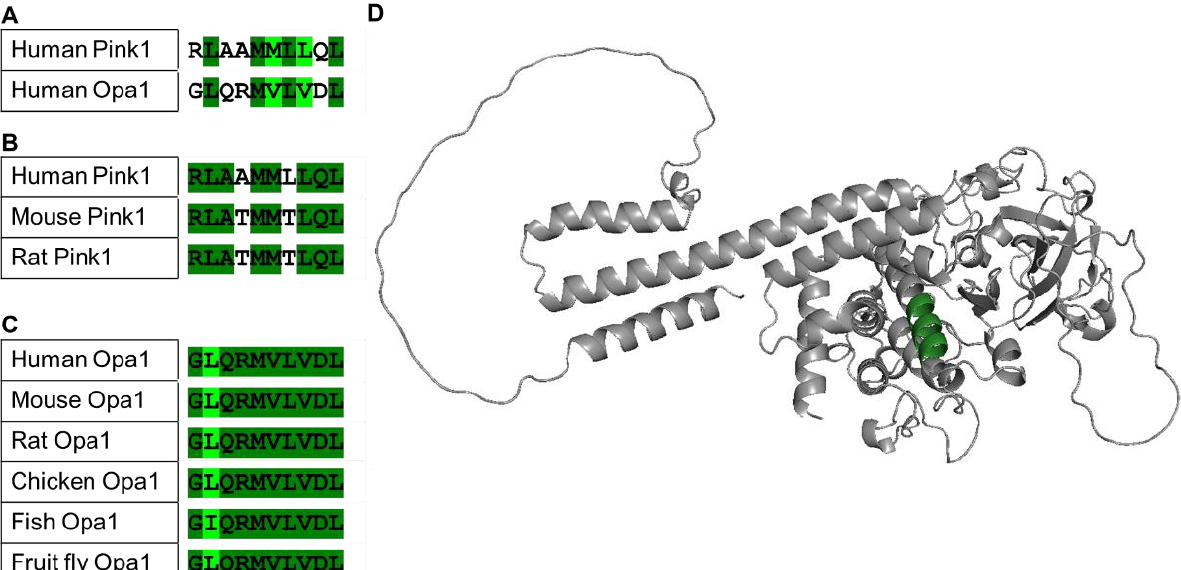
Figure 1. Rational design of a peptide that targets Pink1. Sequence alignment identifies a short sequence of homology between Opa1 and Pink1 ( A ), which is conserved in evolution ( B , C ). The Opa1 sequence (dark green) is exposed in the C-lobe region of Pink1 (AlphaFold predicted model of human Pink1: Q9BXM7) ( D ). PyMol (Schrodinger LLC) was used to generate the figure [24]. 2.2. Identify Pink1 Probe Interaction Sites Using Cross-Linking and Mass Spectrometry Pink1 is a mitochondrial serine/threonine kinase encoded by the PINK1 gene, whose kinase domain is localized in the OMM. This kinase domain is accessible from the cytoplasm and is activated in cells upon mitochondrial membrane depolarization, but the mechanism of activation remains unknown. Pink1 is composed of a mitochondrial targeting sequence located at the N-terminal, a transmembrane helix, an N-terminal regulatory domain, a serine/threonine kinase domain that is constituted by the N-lobe and C-lobe, and the C- terminal portion that has been associated with the regulation of its kinase activity (Figure